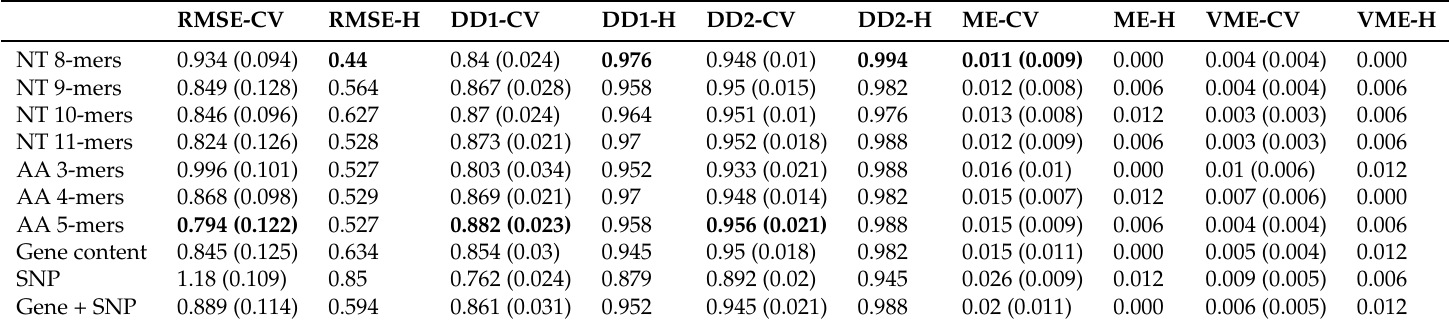
Table A33. K. pneumoniae –meropenem.